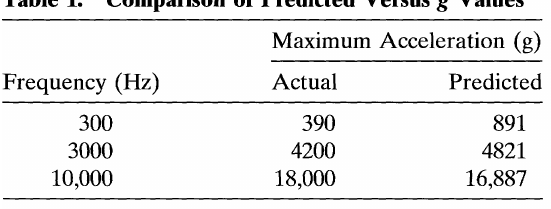
Table 1. Comparison of Predicted Versus g Values Maximum Acceleration (g)